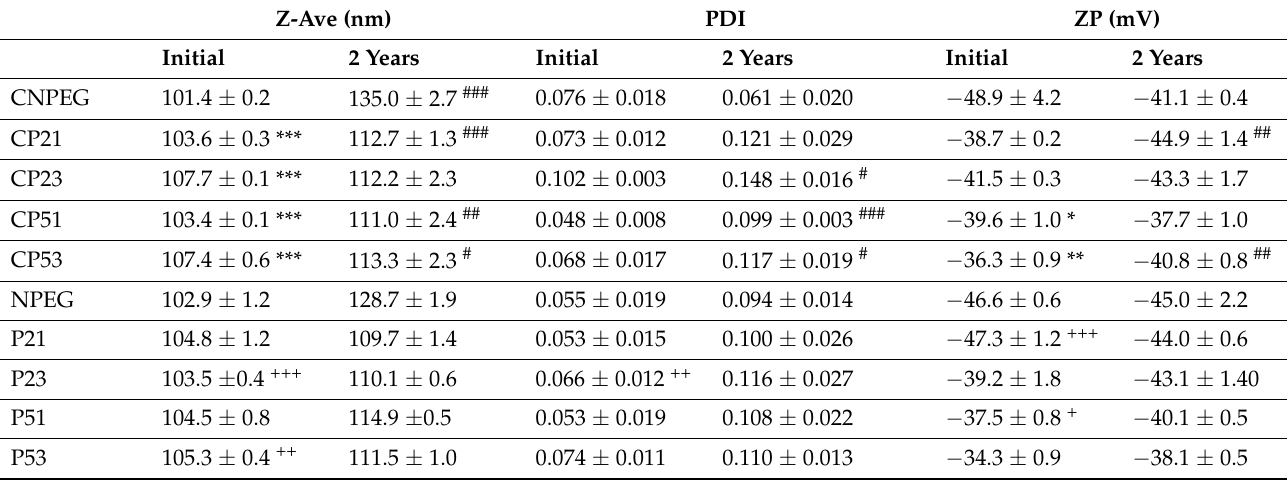
Table 4. Values of Z-ave, PDI and ZP for curcumin-loaded and placebo nanoemulsions measured initially and after two years of storage at room